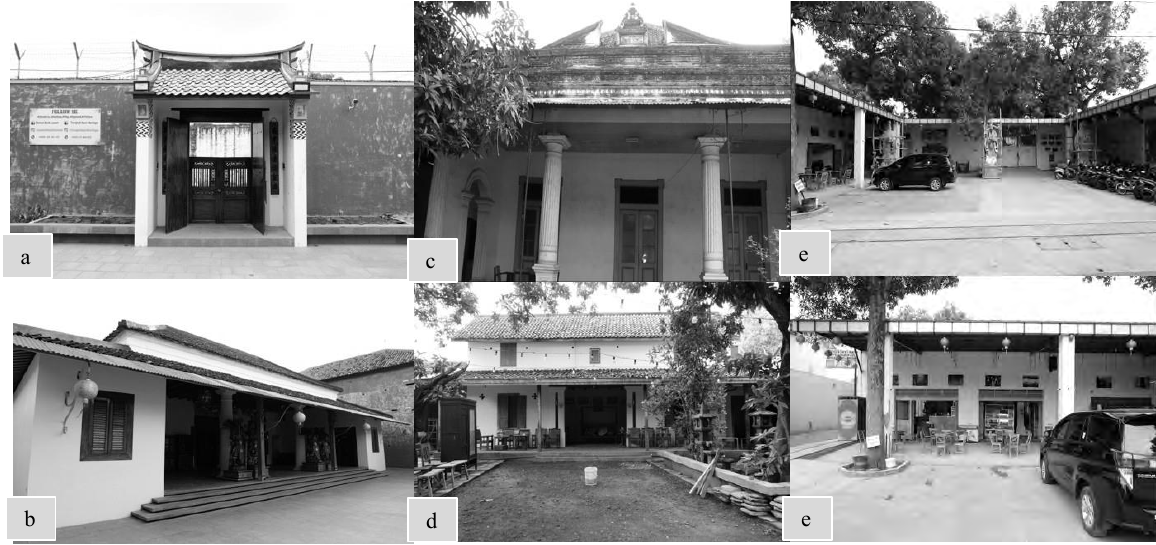
Figure 7. The three main buildings of Little China: (a) the main gate to the homestay building, (b) the entrance of the homestay, (c) the façade of the batik store, (d) the owner’s residence at the backside of the batik store, and (e) the new building for café and parking area